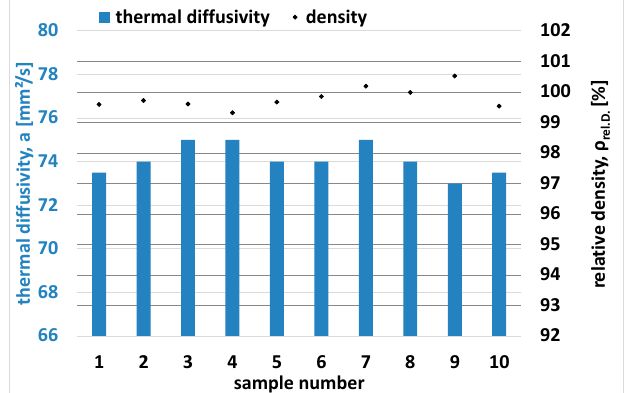
Figure 12. Archimedean density (black dots) as relative density and thermal diffusivity (blue bars) measured via laser-flasher method.